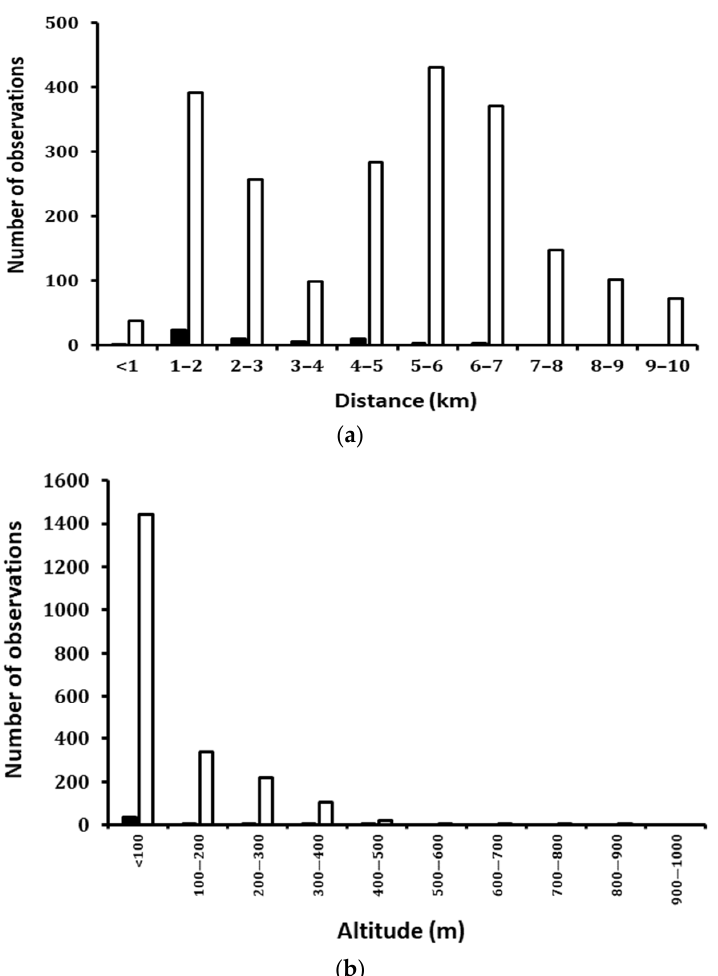
Figure 3. The distribution of the number of red-tailed hawk locations derived from satellite telemetry that were determined to be in the beam of one or more of three radars and were not associated with a radar track (white bars) and well as the number of locations that were associated with a radar track (black bars) with respect to ( a ) the distance of the hawk from the radars (in km) and ( b ) the altitude of the hawk (in m) during a study at Chicago’s O’Hare International Airport, USA, from September 2010 to May 2014. The two top-ranked models, with Akaike weights (w i ) = 0.30 and 0.22, respectively, included distance and angle or only distance as important factors that influenced the